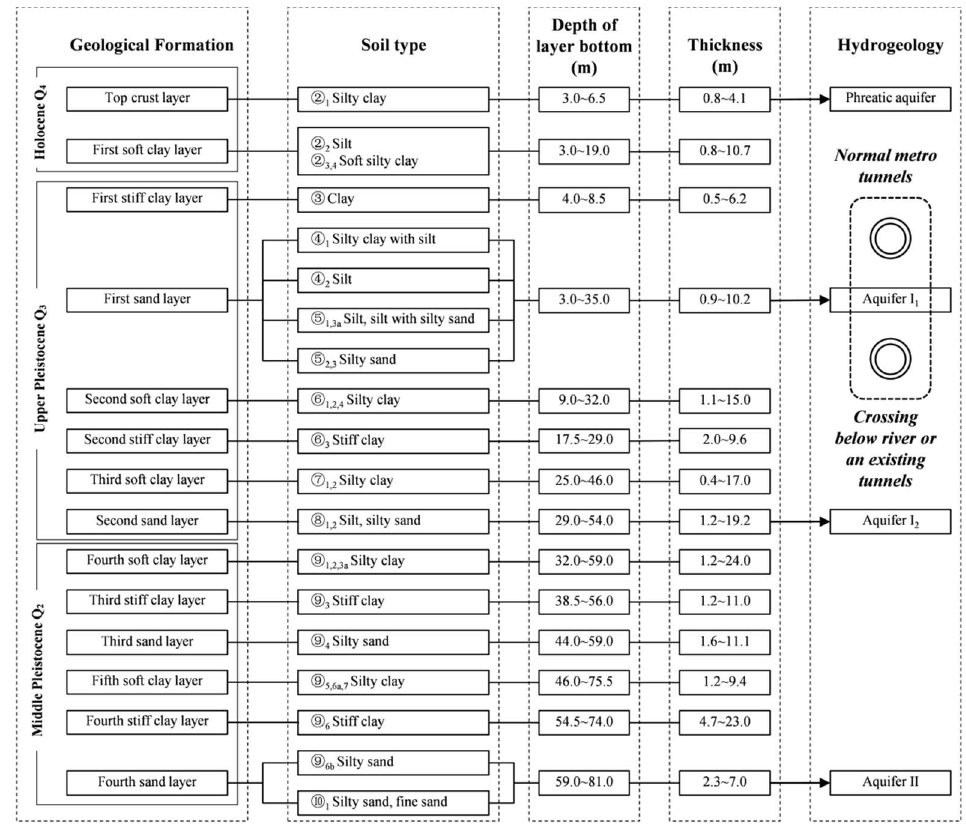
Figure 2. Geology and hydrogeology in Changzhou.